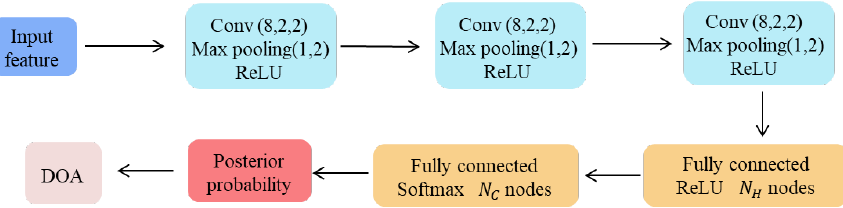
Figure 3. The process for DOAs estimation and architecture in detail. Conv ( x , y , z ) indicates that the size of the convolution core is y × z , and the number of the filters is x . N H is the number of the nodes in the first FC layers. N C is the number of the nodes in the second FC layer, which represents the number of classes.